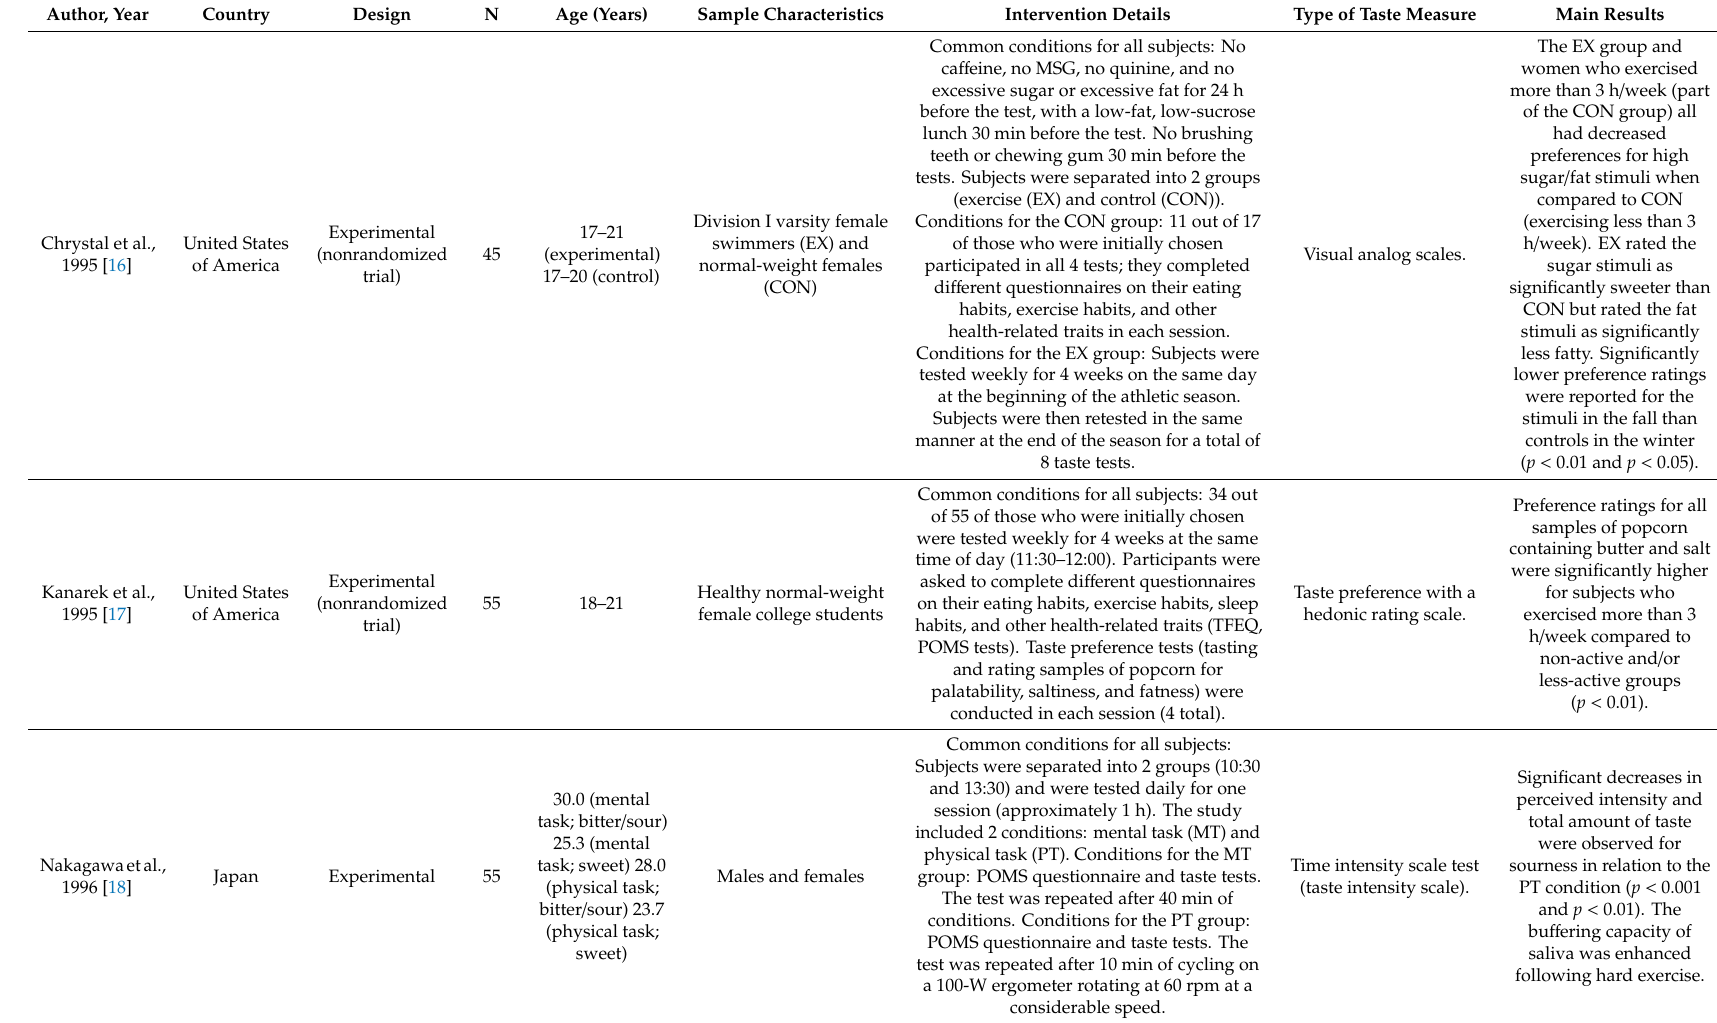
Table 1. Characteristics of included